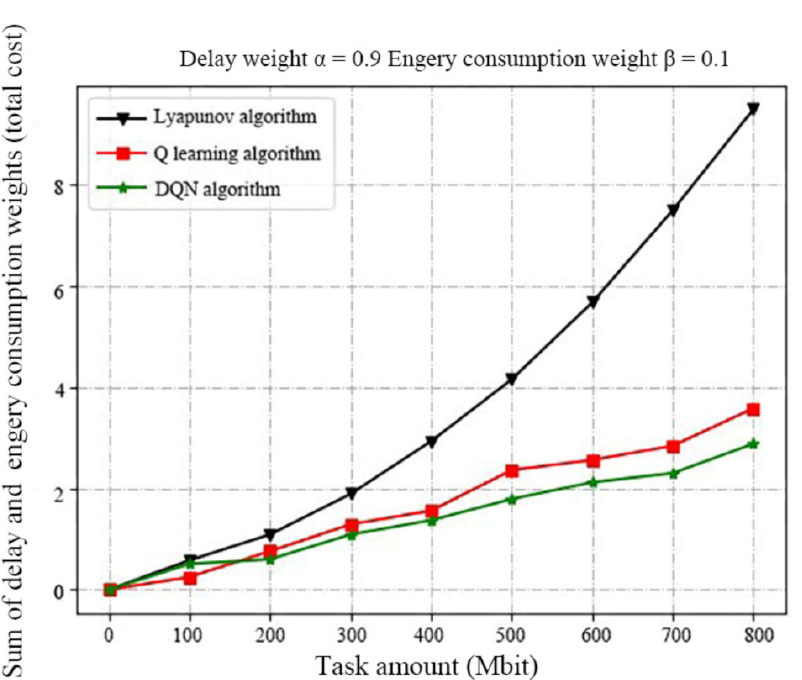
Figure 6. Comparison of total cost when the delay weight is 0.9. Black indicates the computation offloading method based on Lyapunov algorithm, red indicates the computation offloading method based on classical Q-learning algorithm, and green indicates the computation offloading method of DQN algorithm proposed in this paper, comparing the time delay and energy consumption cost of the three approaches under experimentally sensitive task